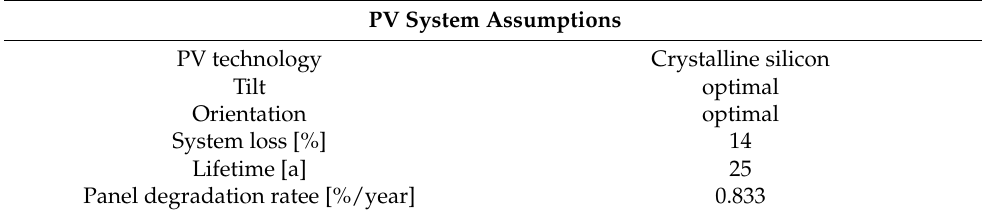
Table 1. PV system parameters used in the simulation